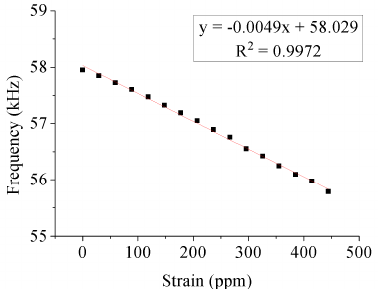
Figure 6. Magnetoelastic sensor resonant frequency vs. strain for a nonmagnetic brass substrate [24].